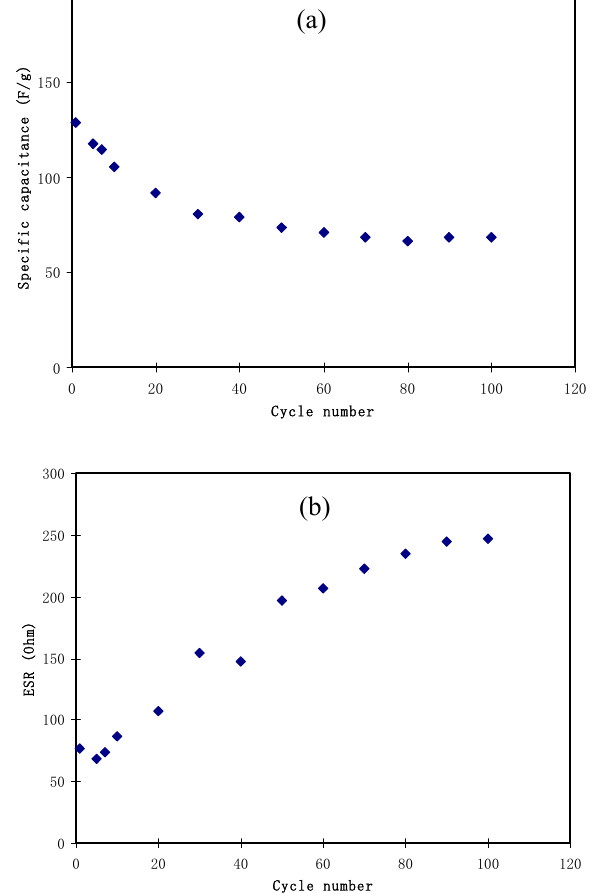
Figure 7. EDLC parameters of ( a ) specific capacitance and ( b ) ESR at 0.5 mA / cm 2 for 100 complete cycles.